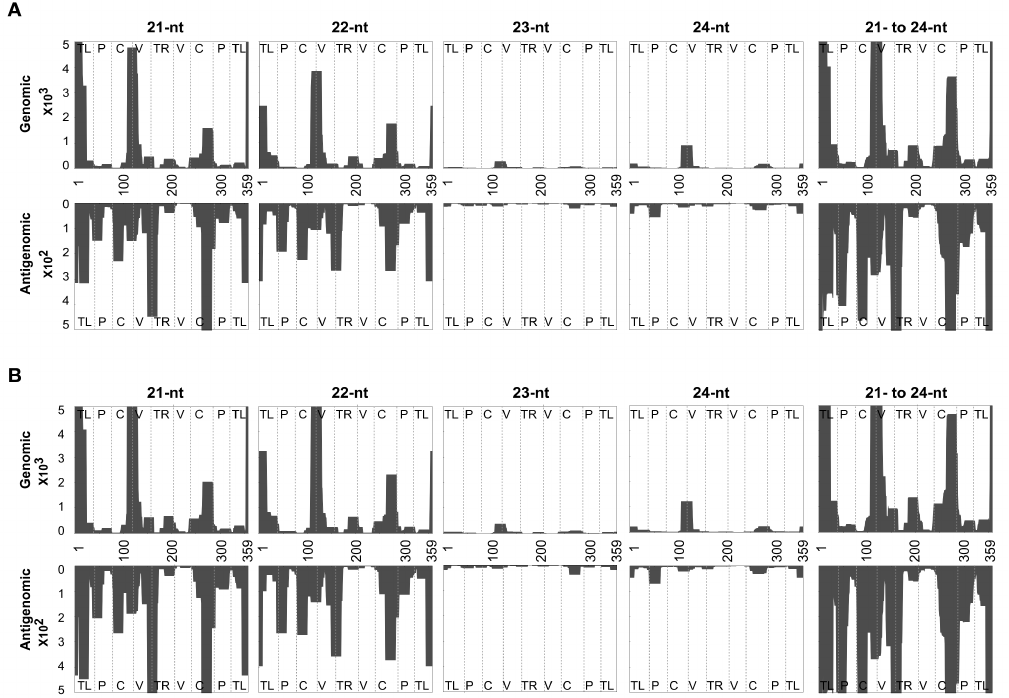
from both the genomic and the antigenomic strands, the mapped vd-sRNAs with both zero and one mismatch were plotted on both the genomic and the antigenomic strands of PSTVd-RG1 (Figure 4). The profiles obtained for 21-, 22-, 23-, 24-nts long vd-sRNAs and the cumulative 21- to 24-nts long vd-sRNAs are presented in Figure 4; panels A and B show zero and one mismatch, respectively.